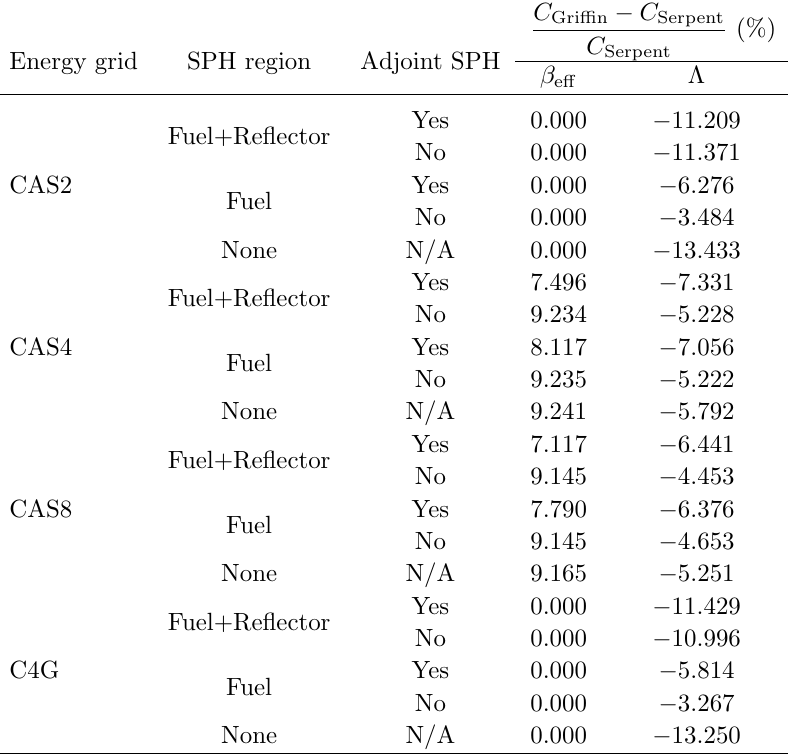
Table 8. Relative differences between Griffin and Serpent kinetics